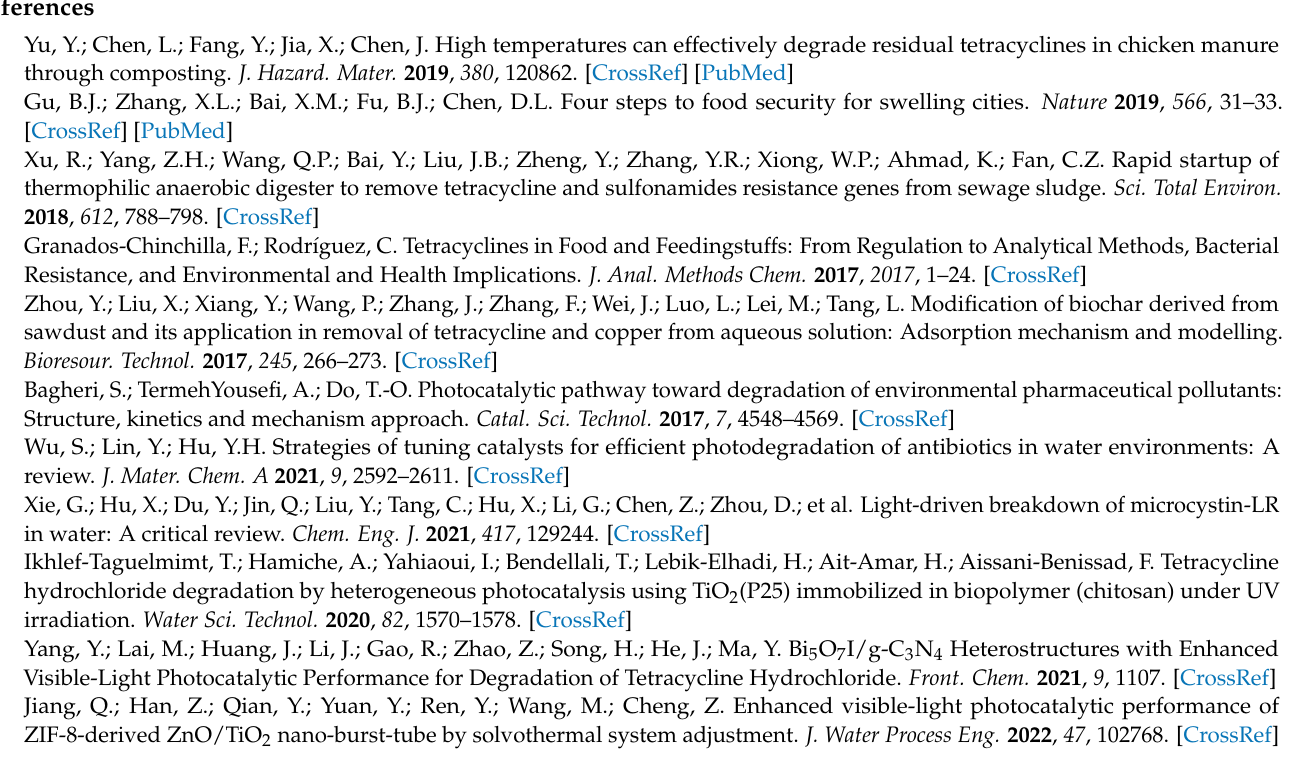
Figure S6. TOC photocatalytic removal efficiencies of TCH (dosage of BiFeO 3 /BC: 0.5 g; pH = 4; C 0(TCH) = 10 mg/L); Figure S7. Comparison of the degradation efficiency of TCH after 90 min of reaction at different pH values. (3 replicates; dosage of BiFeO 3 /BC: 0.5 g; C 0(TCH) = 30 mg/L); Figure S8. Comparison of the degradation rate of TCH after 90 min of reaction at different dosing rates (3 replicates; pH = 4; C 0(TCH) = 10 mg/L); Figure S9. Comparison of the degradation rate of TCH after 90 min of reaction at different initial concentrations. (3 replicates; dosage of BiFeO 3 /BC = 0.05 g; pH = 4). References [17,19,56–58] are cited in Supplementary